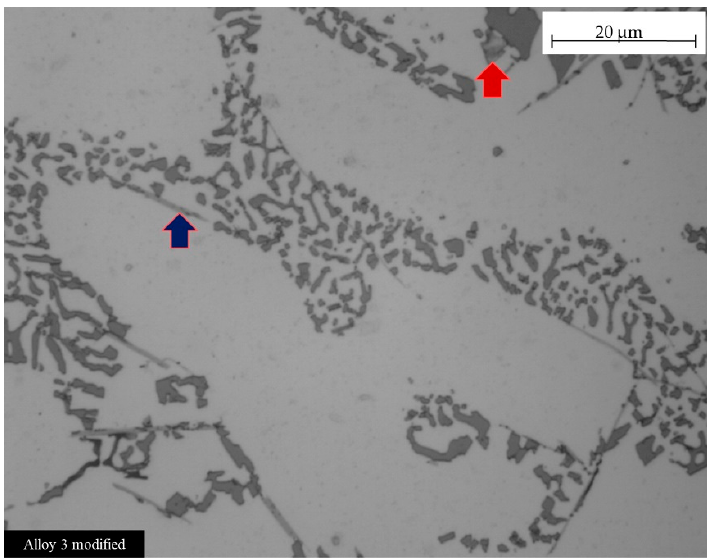
Figure 9. Effect of intermetallic phases on silicon shape. Optical micrograph of alloy 3 modified. Red arrow indicates Fe plate intermetallics; blue arrow indicates acicular Fe intermetallic. The uneven silicon shape is well visible near the inter- metallics.